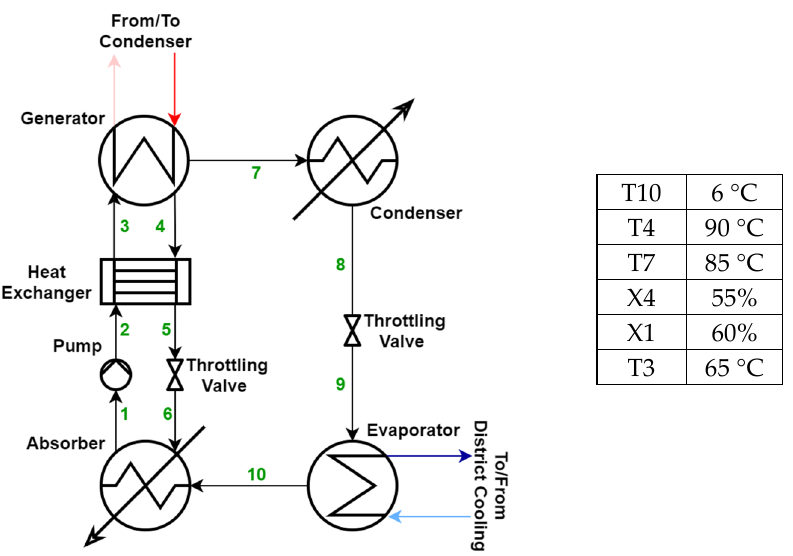
Figure 1. Schematic of the proposed solution; FGHRU: flue gas heat recovery unit; HPT: high-pressure turbine: LPT: low-pressure turbine.